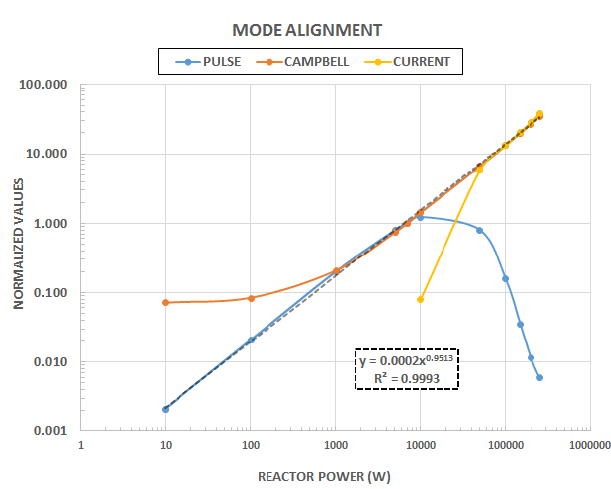
Figure 5: Normalized values of pulse, Campbell and current modes recorded during a reactor power ramp, using MONACO v2 system and FC2288. The dashed line represents the trend curve with associated Chi2 test. Figure 5 also highlights the pulse/Campbell mode overlapping over almost one neutron flux